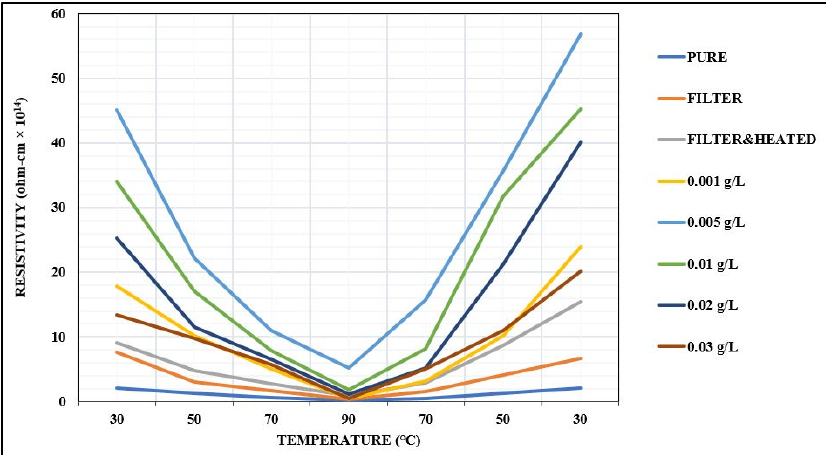
Figure 10. Resistivity values of different types of samples. Table 6. Resistivity (ohm ‐ cm × 10 14 ) value of different type of samples with temperature increasing from 30 °C to 90 °C and falling to 30 °C.